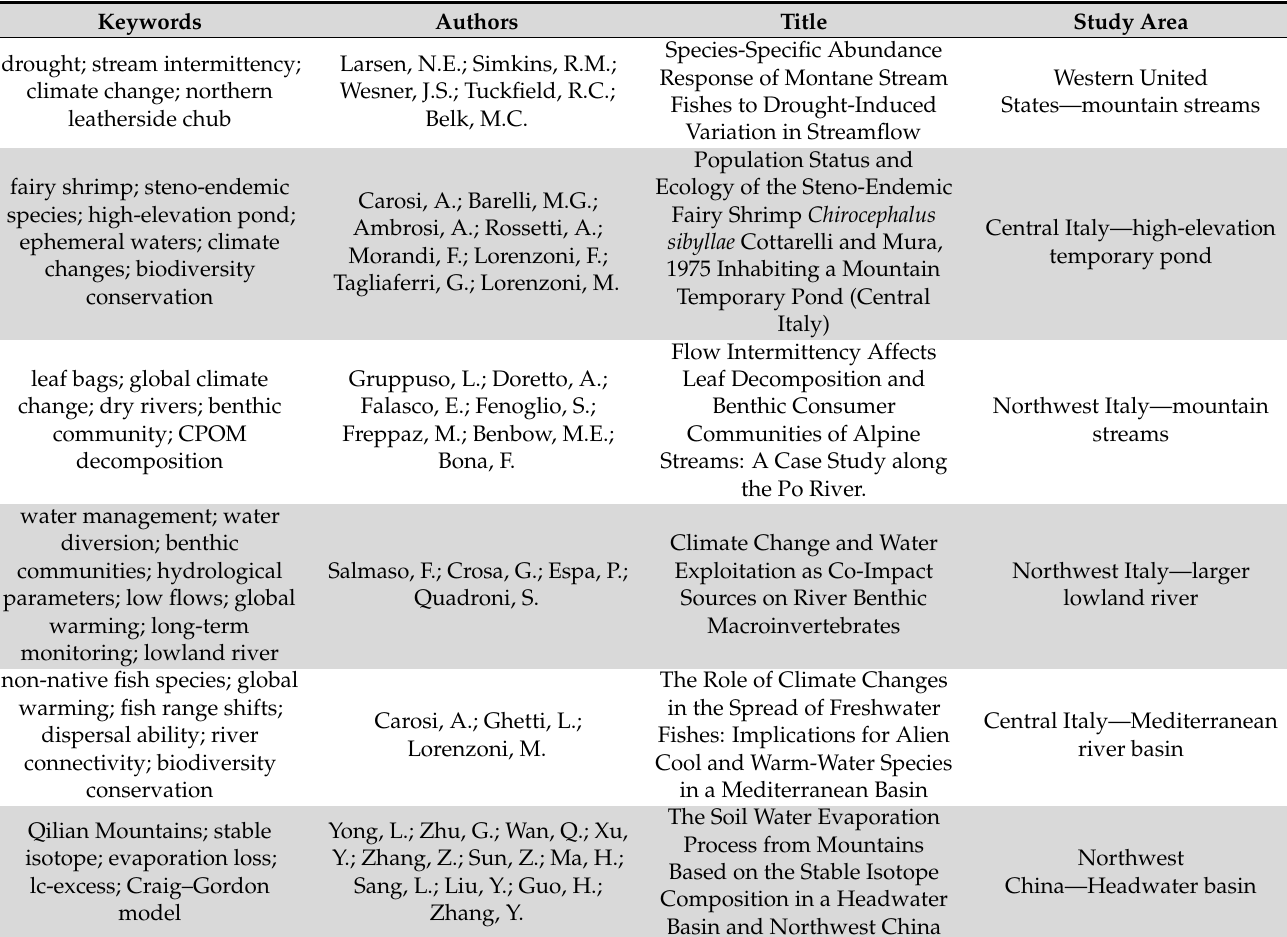
Table 1. Summary of the six papers published in this Special Issue “Effects of Climate Change on Freshwater Biodiversity” in the journal Water (https://www.mdpi.com/journal/water/special_ issues/Climate_Freshwater, accessed on 2 December 2022